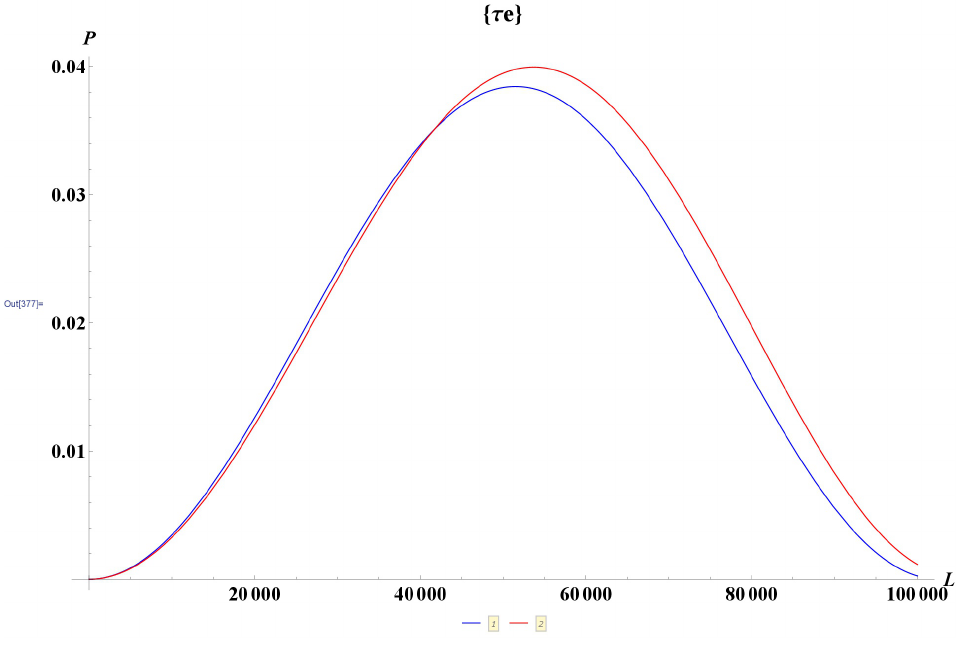
Figure 7. Same of Figure 5, but for P ν